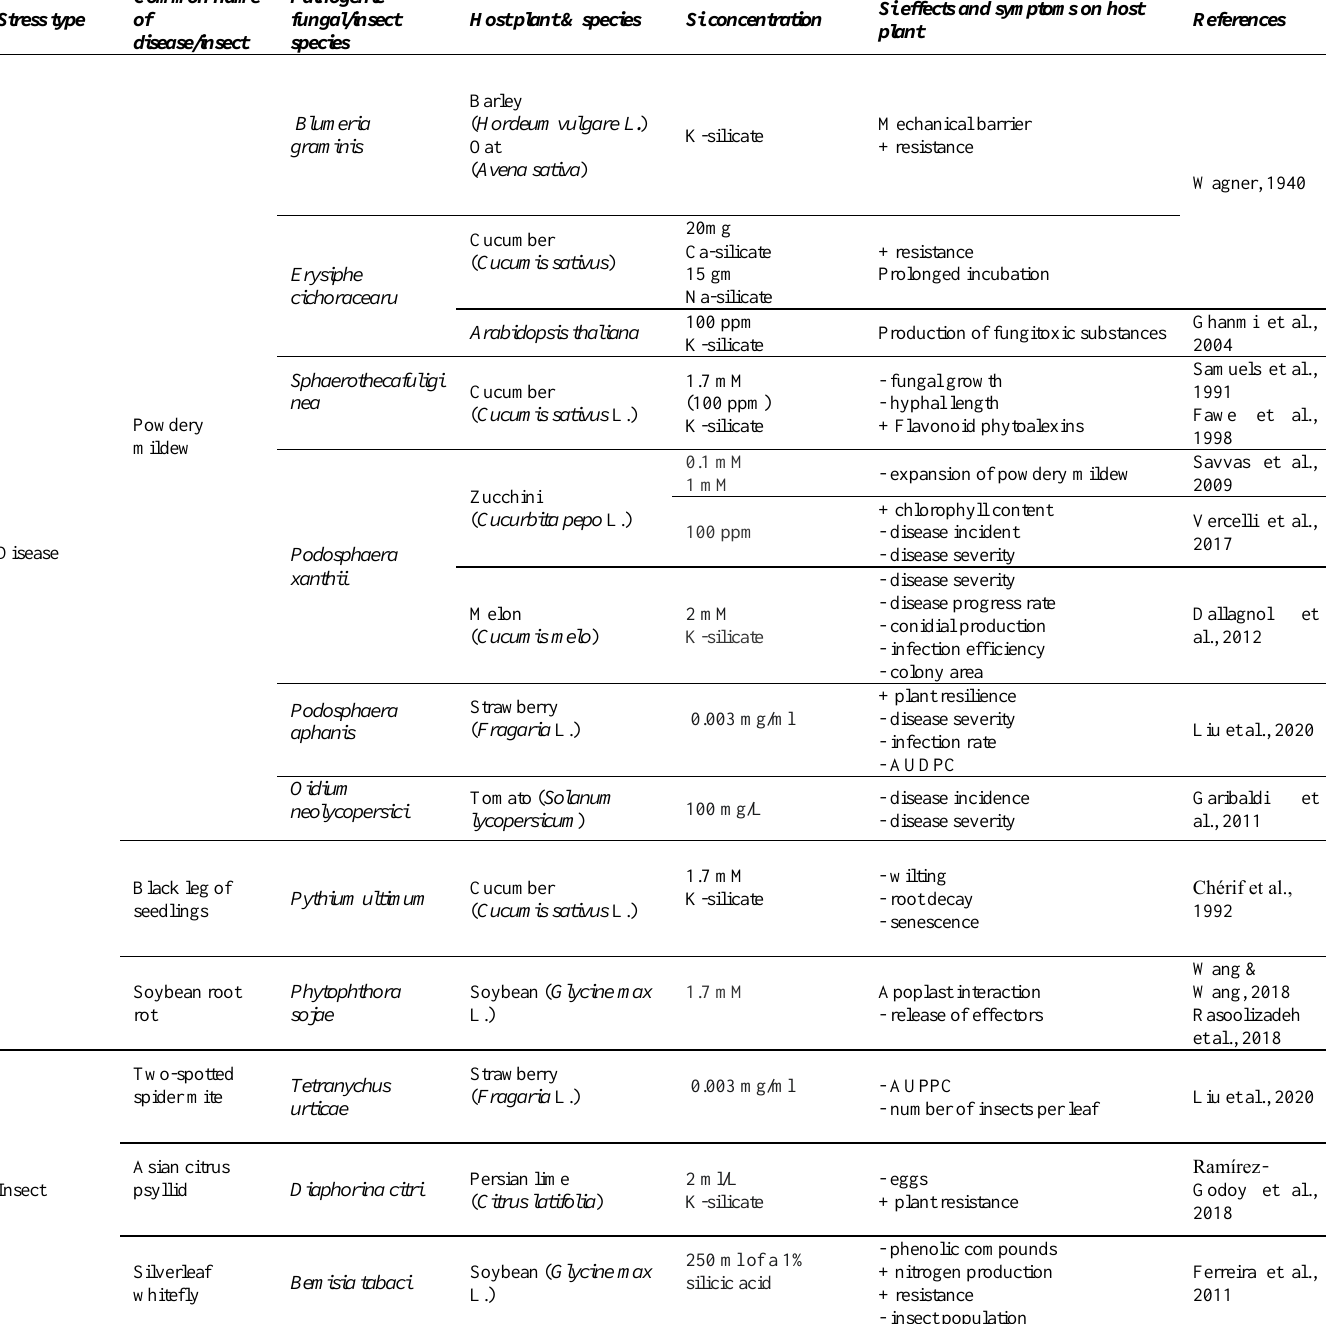
Table 2. Literature summary on effects of Si in biotic stress